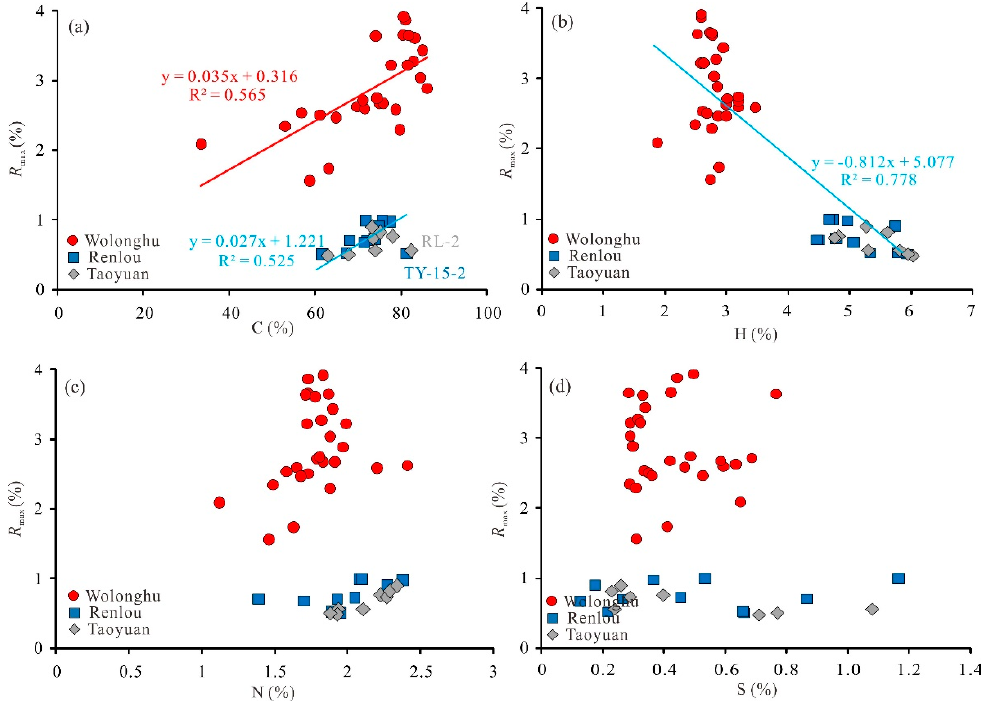
Figure 11. Correlation between conventional element contents C ( a ), H ( b ), N ( c ) and S ( d ) and R max of the selected samples in the Huaibei Coalfield. of the selected samples in the Huaibei